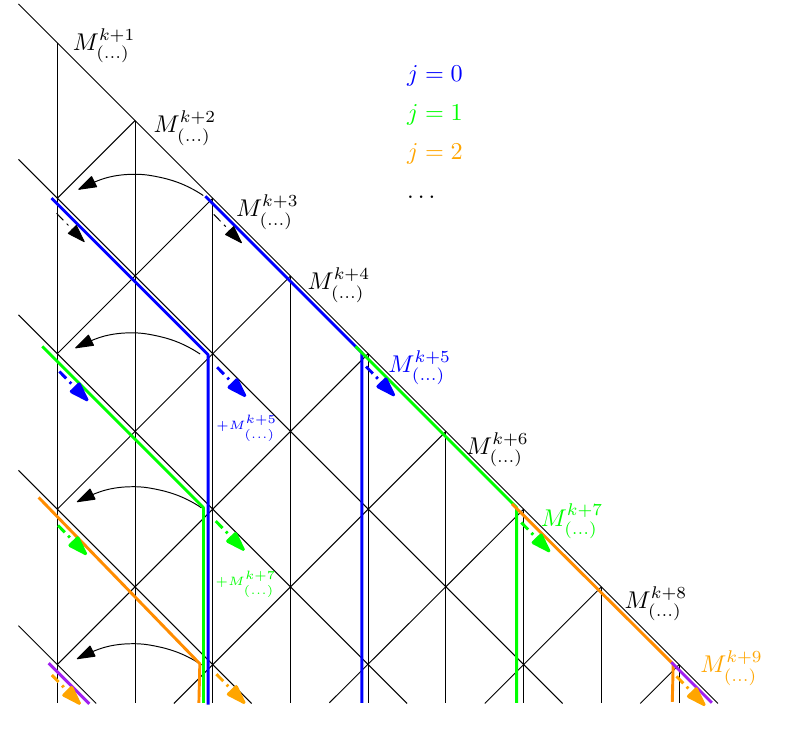
Figure 9. Color emphasizes the number of iterations in the induction. Paths induced at the boundary of ( k + 1 ) -th strip during ( j − 1 ) -th iteration descend in the region, highlighted with color, correspond- ing to j -th iteration. Colored lines outline regions congruent to each other. Dashed colored arrows denote weighted numbers of induced paths, inflicted to ( k + 3 ) -th strip once they have descended, and their equivalents in strips of the auxiliary lattice path